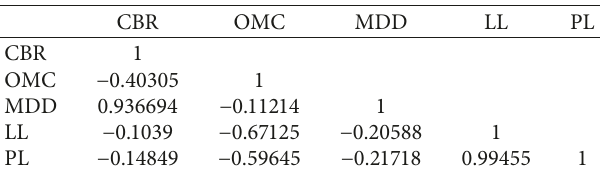
Figure 8: XRD of the test soil. Table 9: Data set for statistical computation. Table 10: Pearson correlation